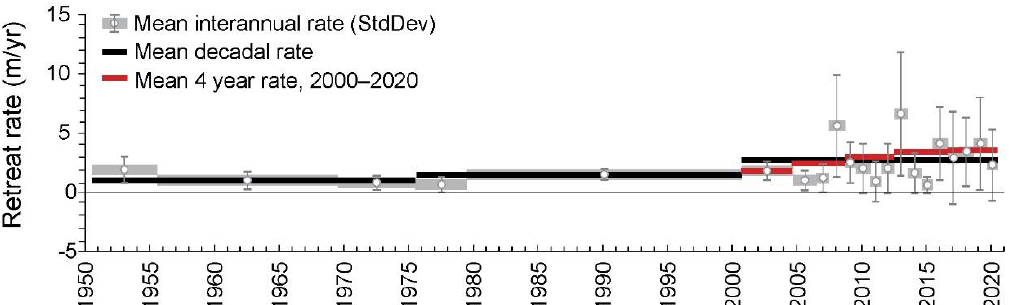
Figure 8. Mean annual retreat rate and standard deviation for the time periods between adjacent bluff datasets (gray), with mean long-term decadal rates (black) and 4 year mean rates from 2000 to 2020 (red) show highly variable, but consistent increase in retreat rates over the study period.